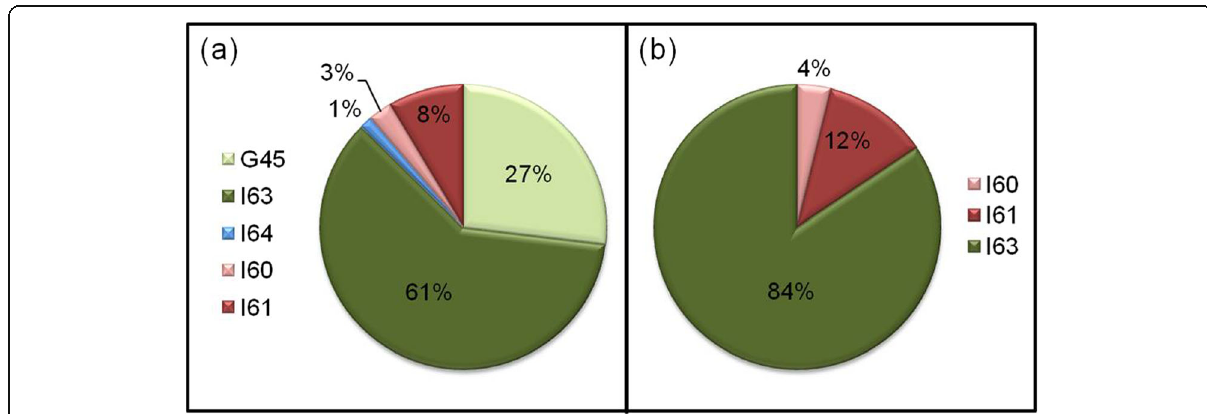
Fig. 1 Distribution of inpatient TIA and stroke cases by diagnostic sub-types in Germany between 2011 and 2017, n = 2.853.370. a ) considering the spectrum of diagnosis typically being treated on SUs and ICUs including TIA (ICD G45, I60, I61, I63, and I64). b ) only considering hemorrhagic and ischemic stroke diagnoses (ICD I60, I61, and I63). G45 = transient ischemic attack, TIA; I63 = acute ischemic stroke, AIS; I64 = stroke not specified; I60 = subarachnoid hemorrhage, SAH; I61 = intracerebral hematoma,